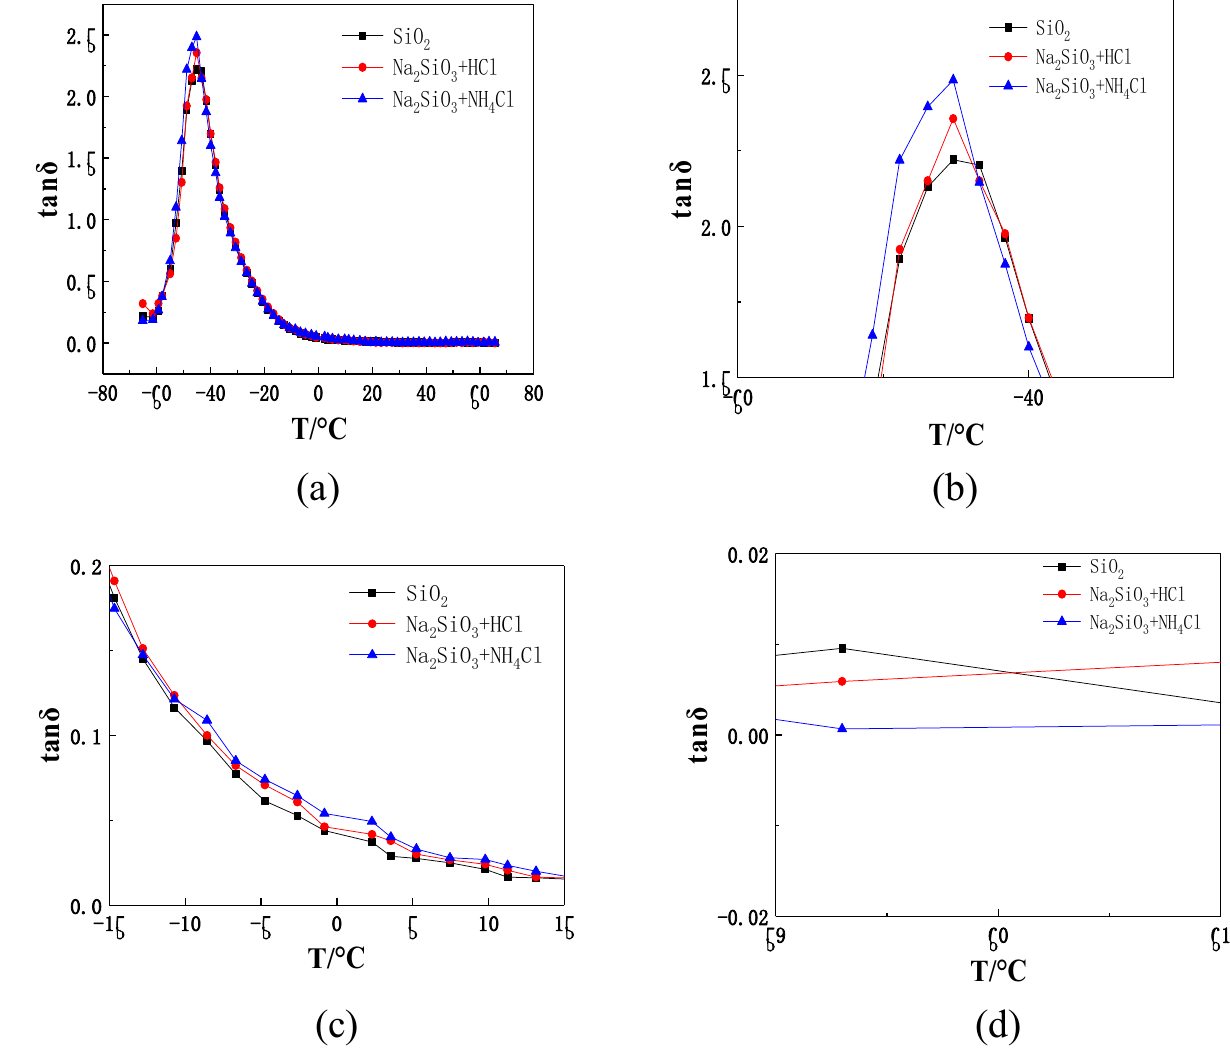
Figure 5: Loss factor - temperature of NR/silica composites with di ff erent processes ( sub fi gures ( b – d ) are partially enlarged drawings of sub fi gure ( a ))